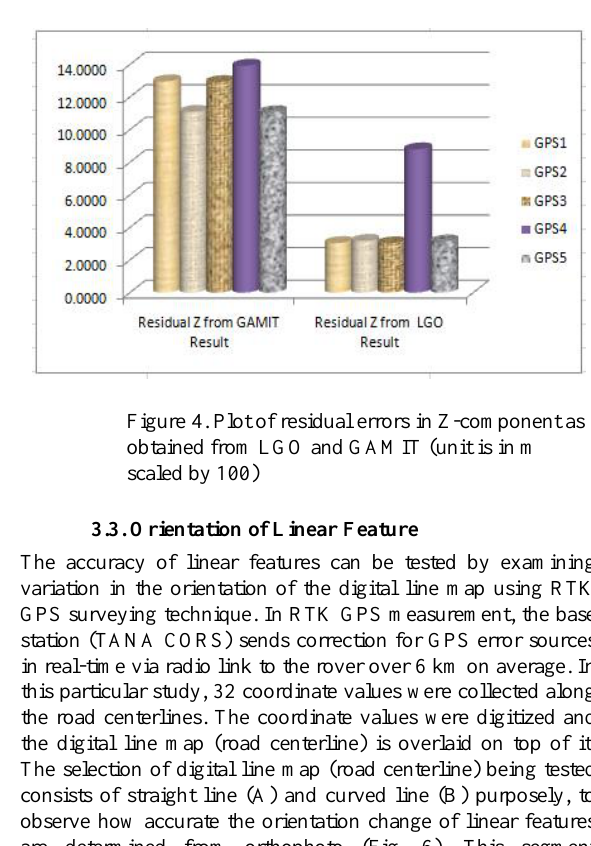
Figure 6. Comparison of orientation in road centreline as acquired from digital line map (red color) and RTK GPS surveying (blue color)